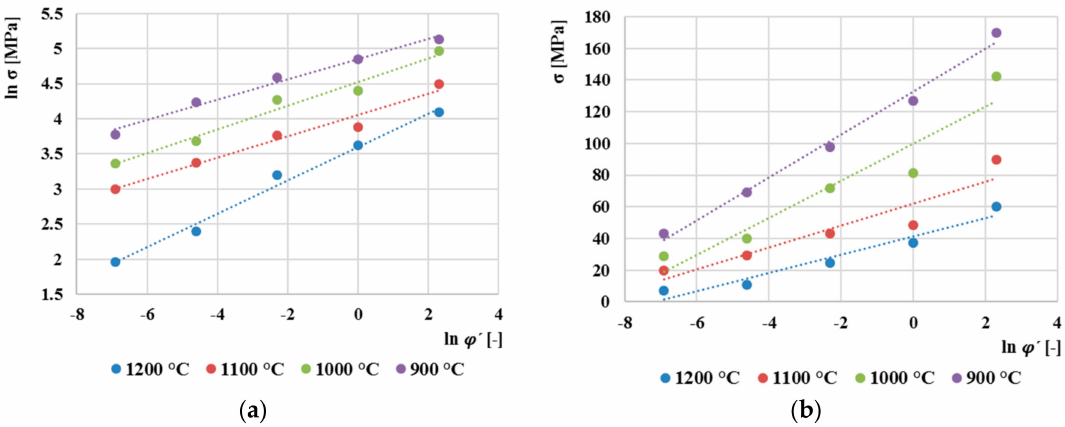
. ϕ and ln σ for derivation of n´ parameter, ( b ) dependence